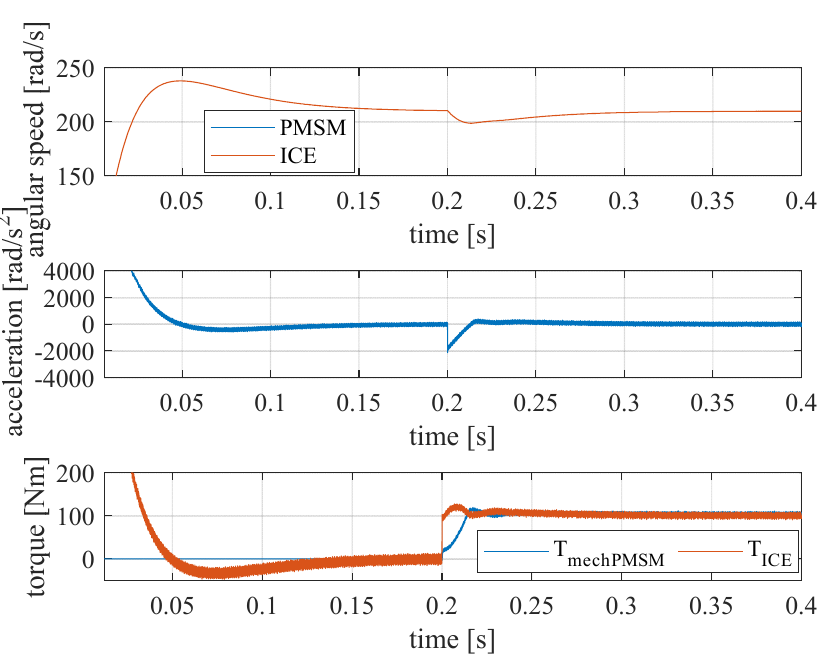
Figure 17. Speed and torques of parallel cooperating of both PMSM motor and ICE engine with damper.